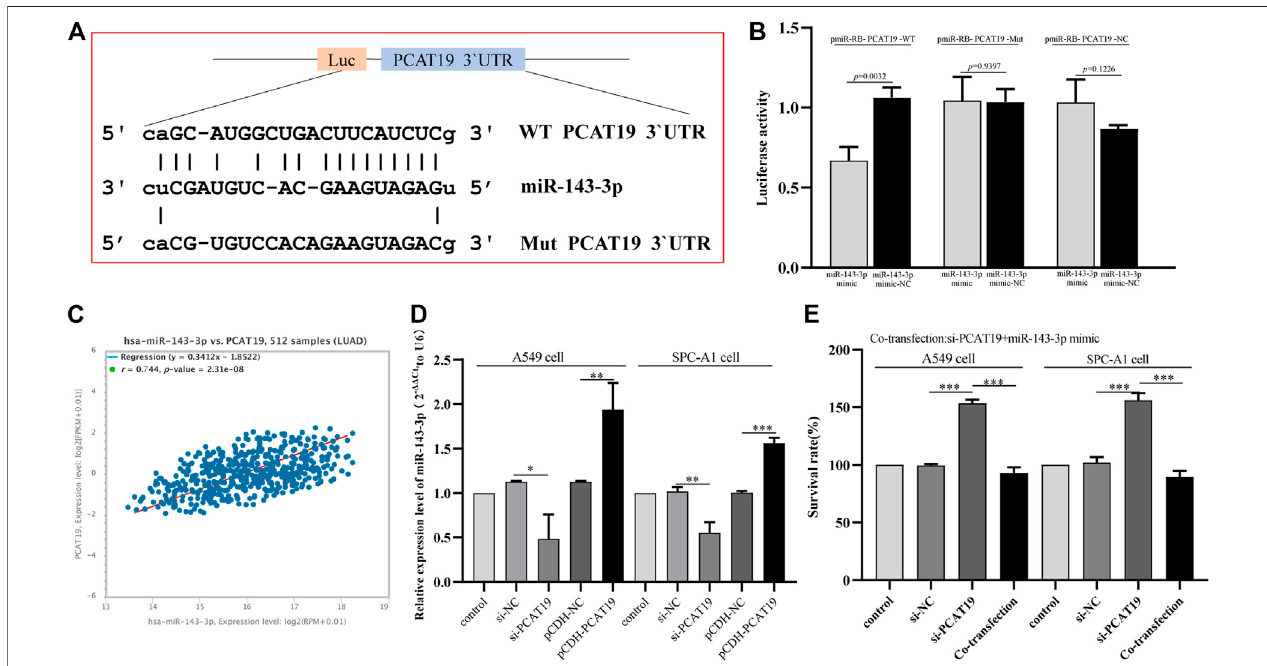
FIGURE 8 | (A) Schematic diagram of the binding site between miR-143-3p and WT or Mut PCAT19. (B) Luciferase activity of WT or Mut PCAT19 after co- transfection of miR-143-3p mimic and WT or Mut PCAT19 dual fl uorescent vector into A549 cells. (C) Correlation between the expression levels of PCAT19 and miR- 143-3p. (D) Expression change of miR-143-3p after PCAT19 knockdown or overexpression in A549 and SPC-A1 cells. The expression level of U6 was used asinternal reference. (E) CCK-8analysisoftheproliferationactivityofA549andSPC-A1cellsco-transfectedwithsi-PCAT19andmiR-143-3pmimic.Thedatashownarethe mean ± standard deviation of three experiments. * p < 0.05, ** p < 0.01, *** p <